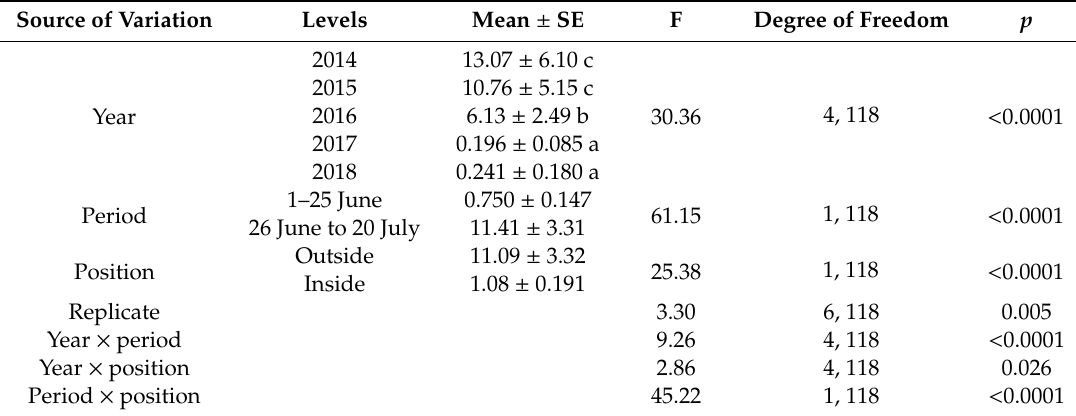
Table 1. Captures of Hyalesthes obsoletus recorded from 2014 to 2018 in vineyard A habitat. Source of Variation